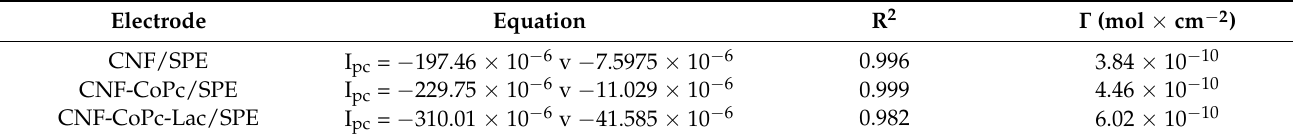
Figure 8. Cyclic voltammograms of CNF-CoPc/SPE ( a ) and CNF-CoPc-Lac/SPE ( b ) recorded at various scan rates within the range 0.1–1.0 V/s.